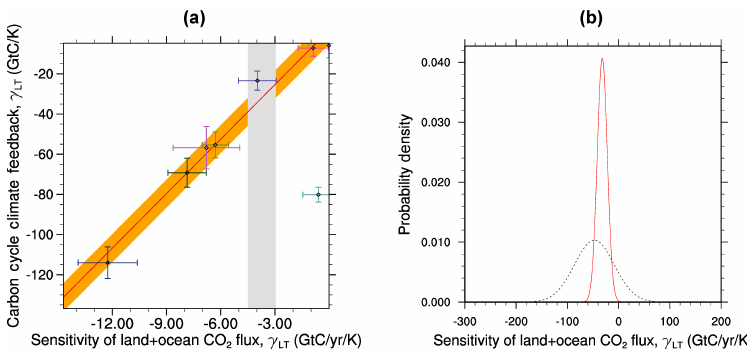
Figure 26. (a) The carbon cycle-climate feedback ( γ LT ) versus the short-term sensitivity of atmospheric CO 2 to interannual temperature variability ( γ IAV ) in the tropics for CMIP5 models. The red line shows the best fit line across the CMIP5 simulations and the grey-shaded area shows the observed range of γ IAV . (b) Probability distribution function (PDF) for γ LT . The solid line is derived after applying the interannual variability (IAV) constraint to the models while the dashed line is the prior PDF derived purely from the models before applying the IAV constraint. The results show a tight correlation between γ LT and γ IAV that enables the projections to be constrained with observations. The conditional PDF sharpens the range of γ LT to − 44 ± 14GtCK − 1 compared to the unconditional PDF which is ( − 49 ± 40GtCK − 1 ). Similar to Fig. 9.45 of Flato et al. (2013) and reproducing the CMIP5 model results from Fig. 5 of Wenzel et al. (2014) with